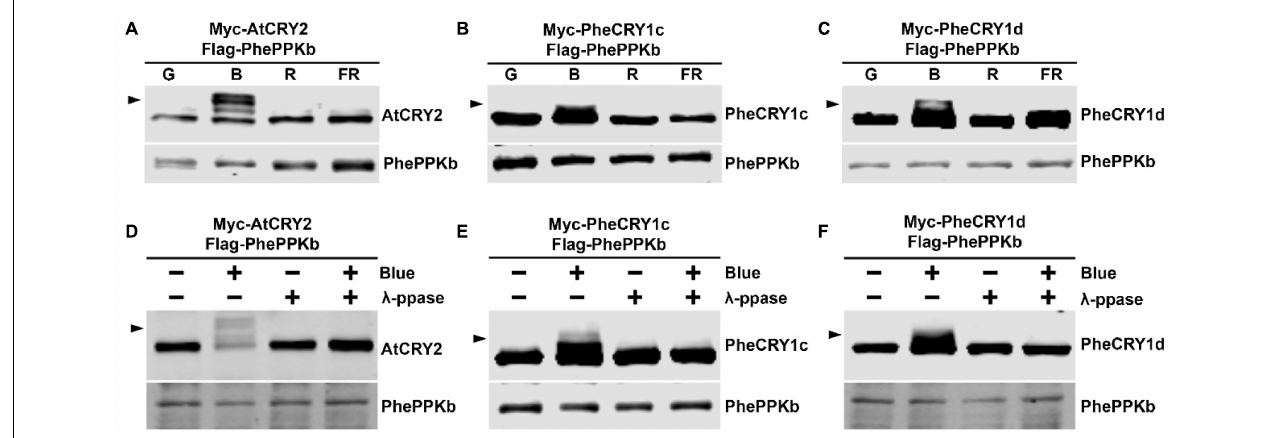
FIGURE 7 | Bamboo PhePPKb catalyzes the blue light-dependent phosphorylation of bamboo PheCRY1 in HEK293T cells. (A–C) Cells co-expressing indicated plasmid pairs were exposed to green light (G, 50 µ molm − 2 s − 1 ), blue light (B, 50 µ molm − 2 s − 1 ), red light (R, 50 µ molm − 2 s − 1 ), or far-red light (FR, 5 µ molm − 2 s − 1 ) for 60 min. Immunoblots were probed with the anti-Myc or anti-Flag antibodies. (D–F) Cells co-expressing indicated plasmids were kept in the dark (Blue –) or treated with 100 µ molm − 2 s − 1 of blue light for 2 h (Blue +). Lysates were treated without (- λ -PPase) or with λ -PPase (+ λ -PPase), and analyzed by immunoblots probed with the anti-Flag or anti-Myc antibodies. Arrowheads indicate the phosphorylated